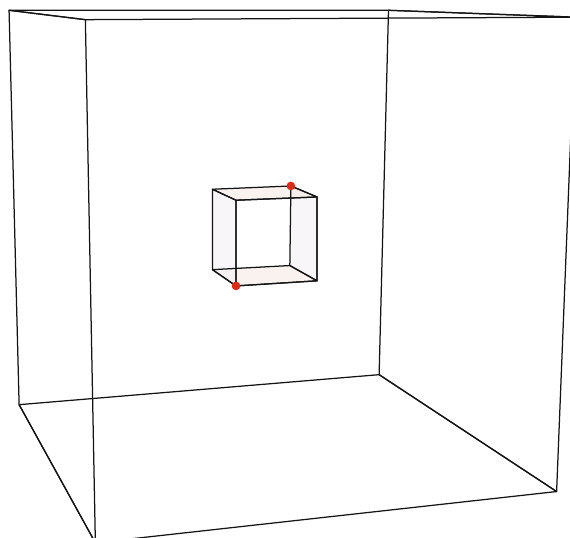
Figure 2: Two opposite corners of a cuboid in the 3D